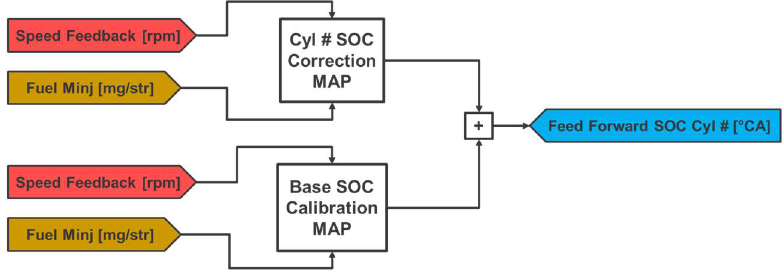
Figure 5. Schematic of the feed-forward model defining the base value of SOC.